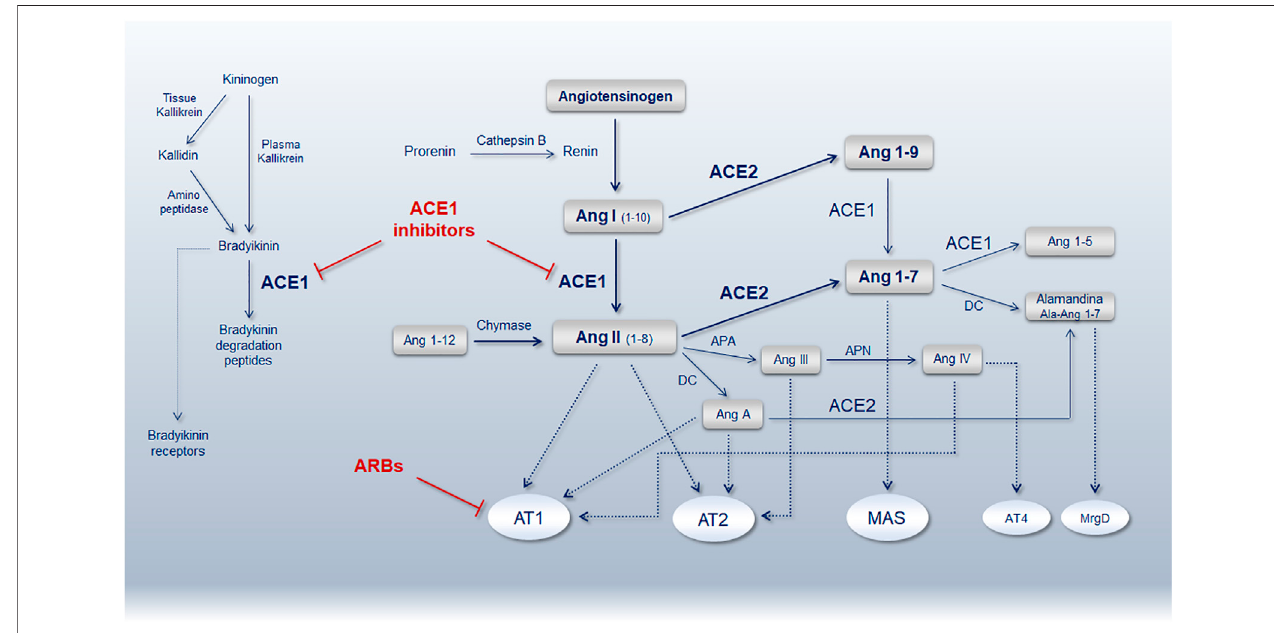
FIGURE2| Schematicrepresentationoftherenin-angiotensin-system(RAS)pathwayshowingthemainbioactivepeptidesandkeyreceptors.ACE1,angiotensin- converting enzyme 1; ACE2, angiotensin-converting enzyme 2; Ang, angiotensin; AT1R, Ang-II type 1 receptor; AT2R, Ang-II type 2 receptor; ARBs, angiotensin receptor blockers; MAS, Mas receptor; AT4R, angiotensin receptor type 4; MrgD, MAS-related G protein-coupled receptor member D; APA, aminopeptidase A; APN, aminopeptidase N; DC, decarboxylase (Reproduced from Gemmati et. al. Genes. 11 (9), 1044. doi:10.3390/genes11091044) (Gemmati and Tisato, 2020).